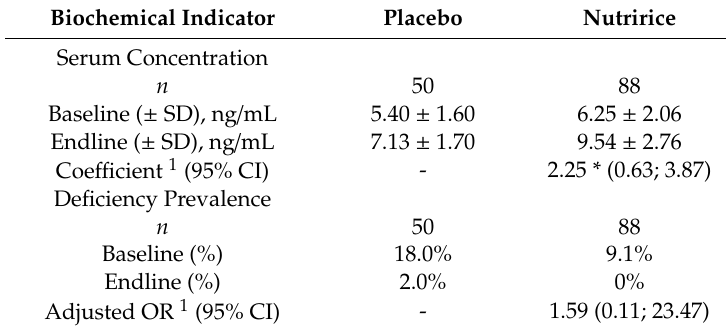
Table 6. Biochemical outcomes of folate concentration and deficiency of participating children. Biochemical